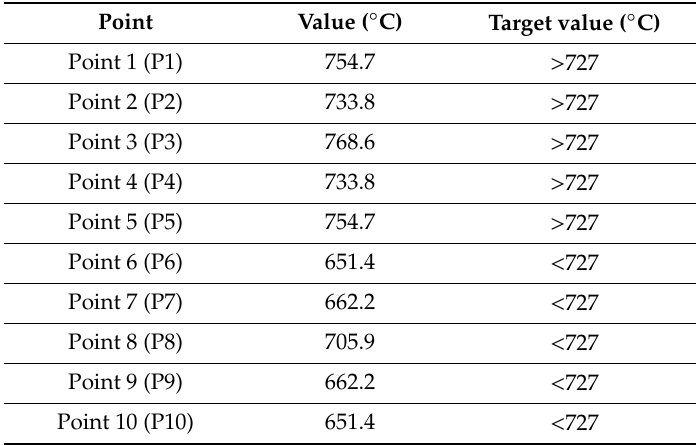
Table 10. Analysis results by measurement location.